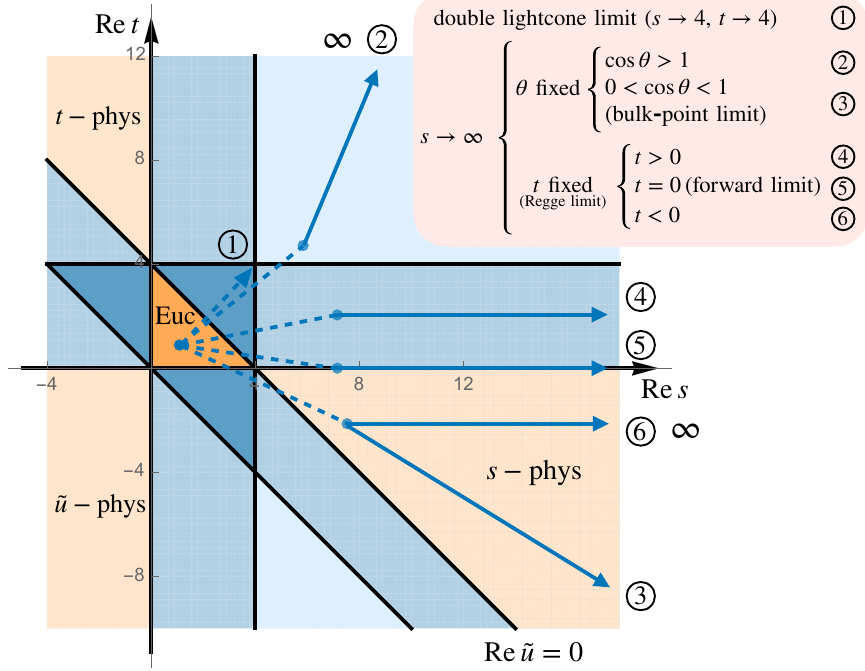
Figure 20. Different kinematic limits in real s − t plane. The dark blue dashed lines indicate analytic continuation of s, t into their complex planes, respectively. Details of analytic continuation are explained in the text. The dark blue arrows lie on the real s − t plane. The orange triangle is the Euclidean region, and within it lies the starting point of all limits and their corresponding analytic